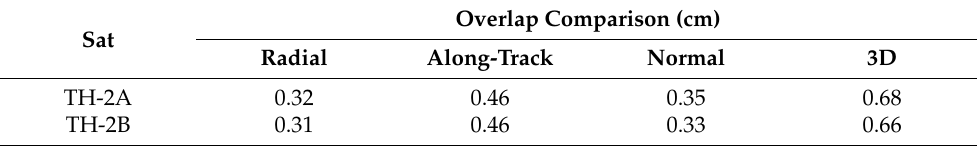
Table 3. Average RMS of overlap comparisons for GPS-based orbit solutions for TH-2A and TH-2B.